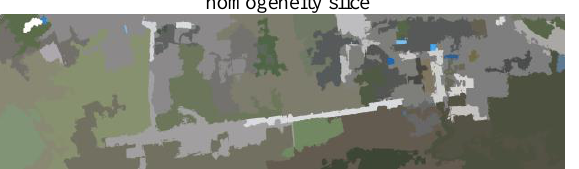
Figure 11. The optimal segmentation using uniform homogeneity slice